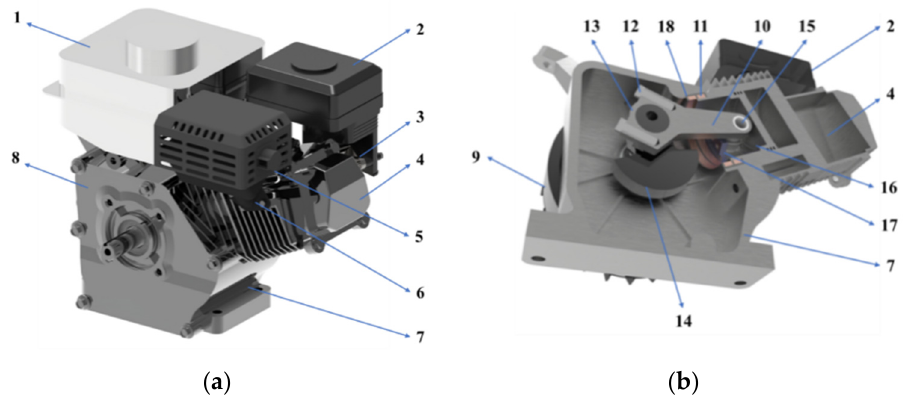
Figure 1. 3D model of the PMPMEE: ( a ) Isometric side view; ( b ) Half section view. 1—Fuel tank; 2—Filter; 3—Carburetor; 4—Combustion chamber cover; 5—Muffler; 6—Exhaust duct; 7—Cylinder